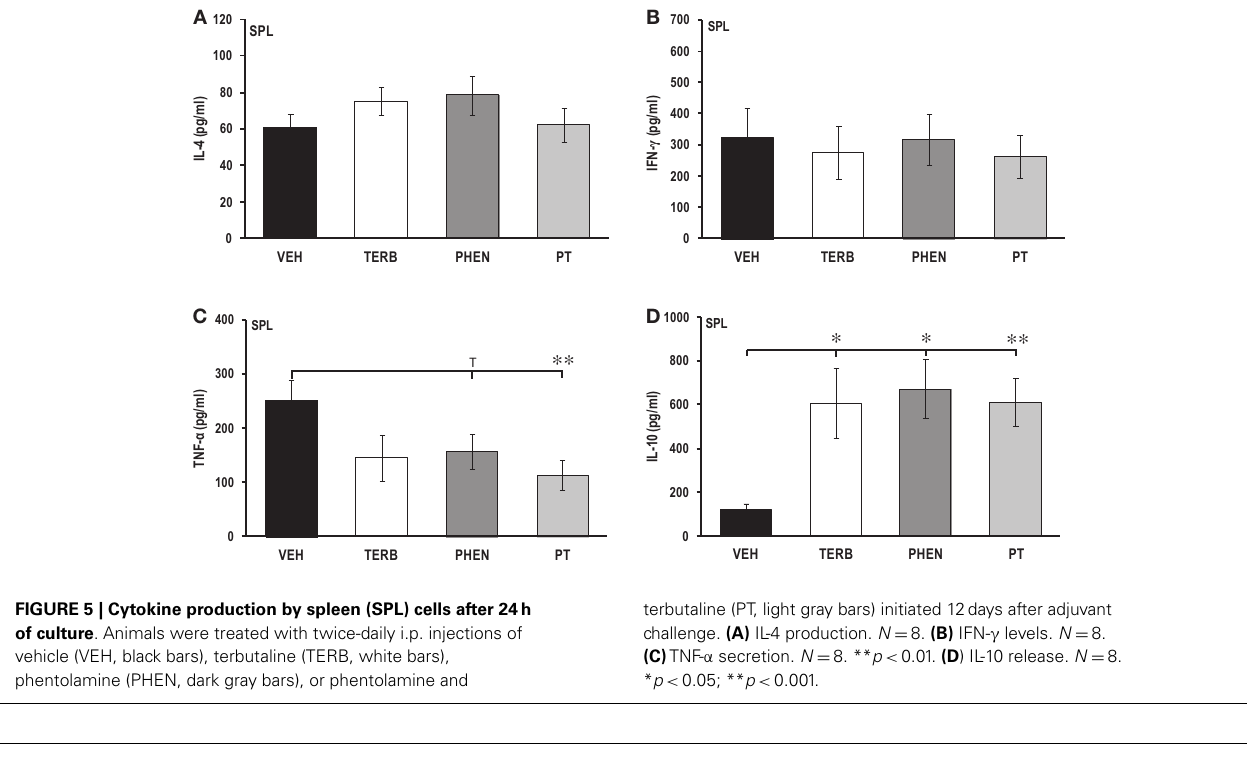
terbutaline (PT, light gray bars) initiated 12days after adjuvant challenge. (A) IL-4 production. N = 8. (B) IFN- γ levels. N = 8.